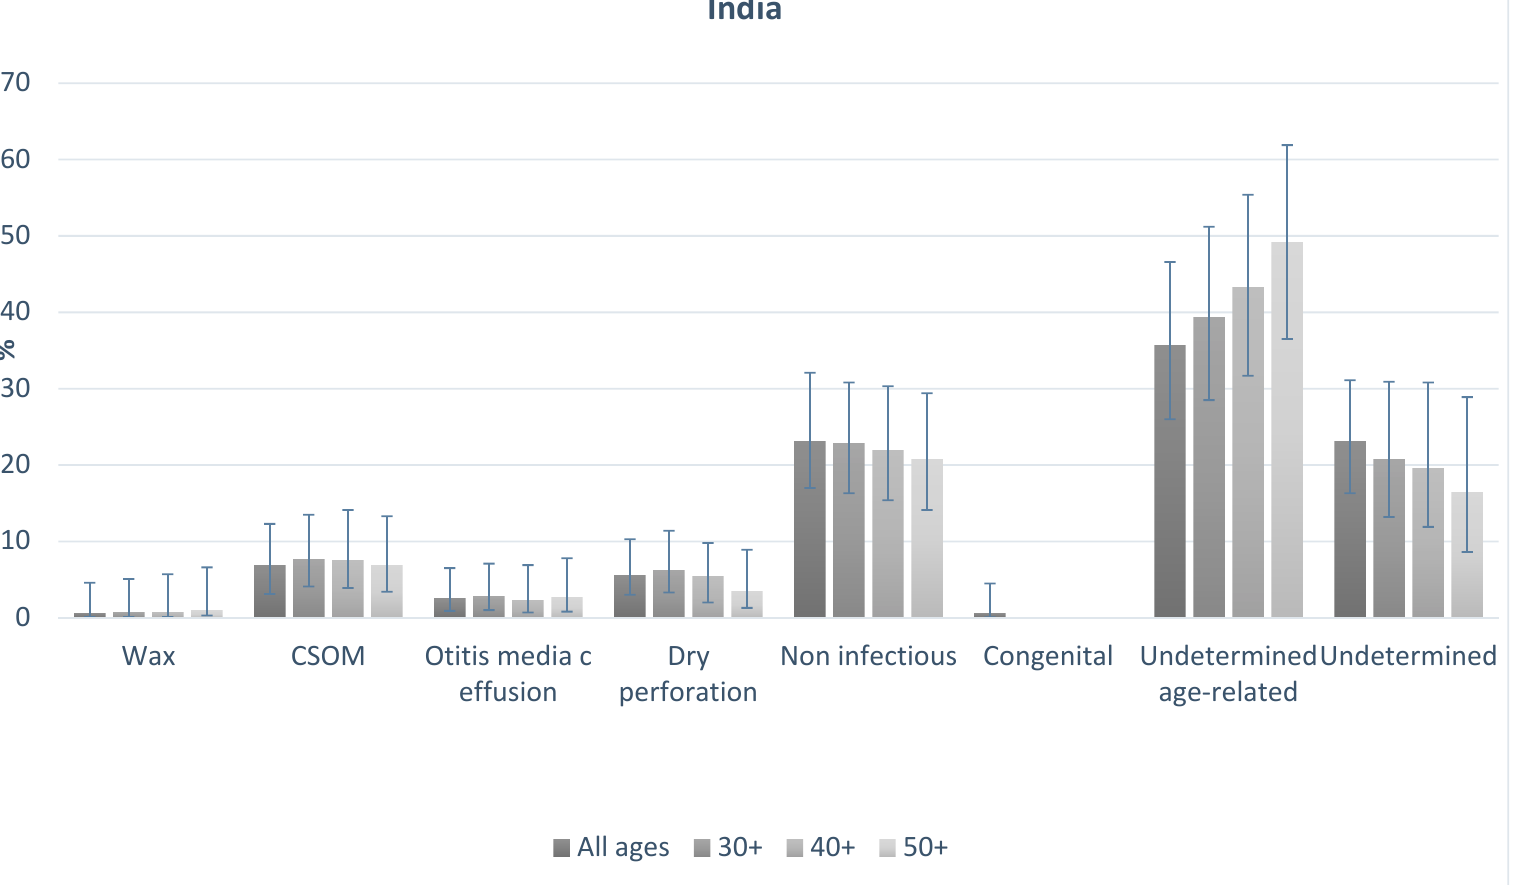
Figure 1. Probable causes of hearing loss in the population for all-ages and those aged 30, 40 and 50 plus in India